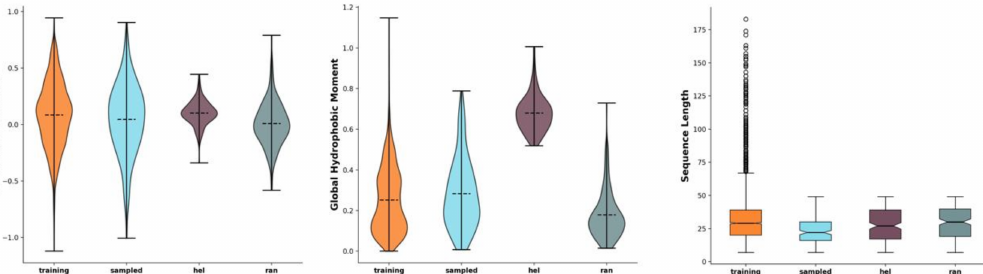
Figure 1. Comparison of peptide characteristics between the training data (Training, orange), the generated sequences (Sampled, blue), the pseudo-random sequences with the same amino acid distribution as in the training set (Ran, purple), and the manually created hypothetical amphipathic helices (Hel, green). The horizontal dashed lines represent the mean (violin plots) and median (box plots) values; the whiskers extend to the outermost non-outlier data points. Graphs from left to right: Eisenberg hydrophobicity, Eisenberg hydrophobic moment, and sequence length. The figure was generated using the modlAMP’s GlobalAnalysis.plot_summary method in Python [16].